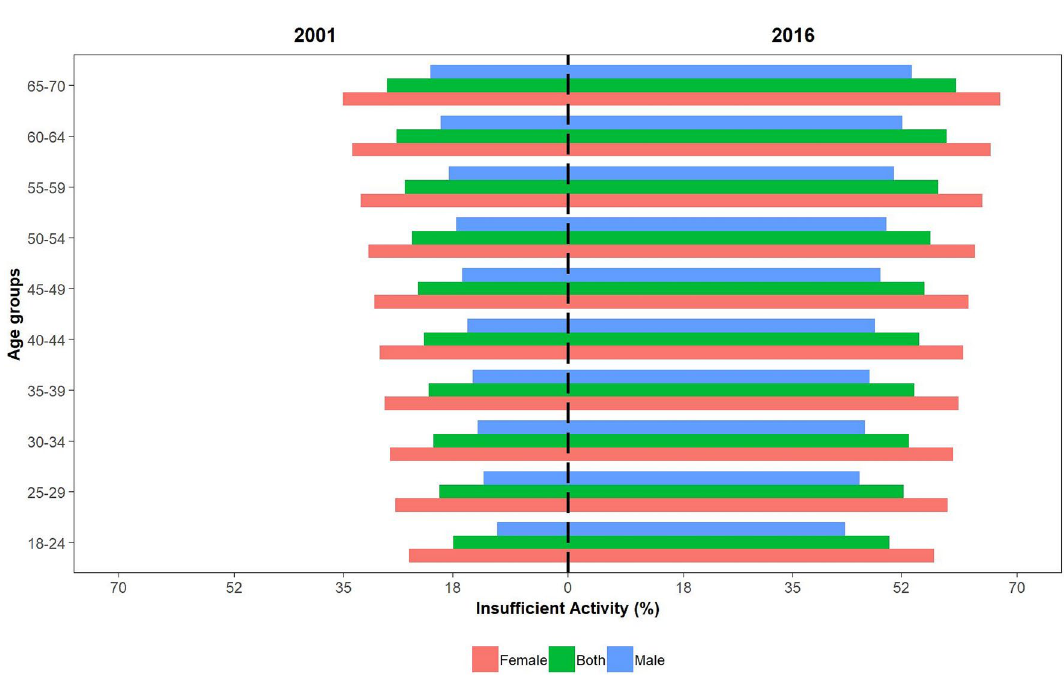
Figure 2. The prevalence of IPA in 2001 and 2016 is demonstrated below for male, female, and both genders. IPA: insufficient physical activity; 95% UI: 95% uncertainty